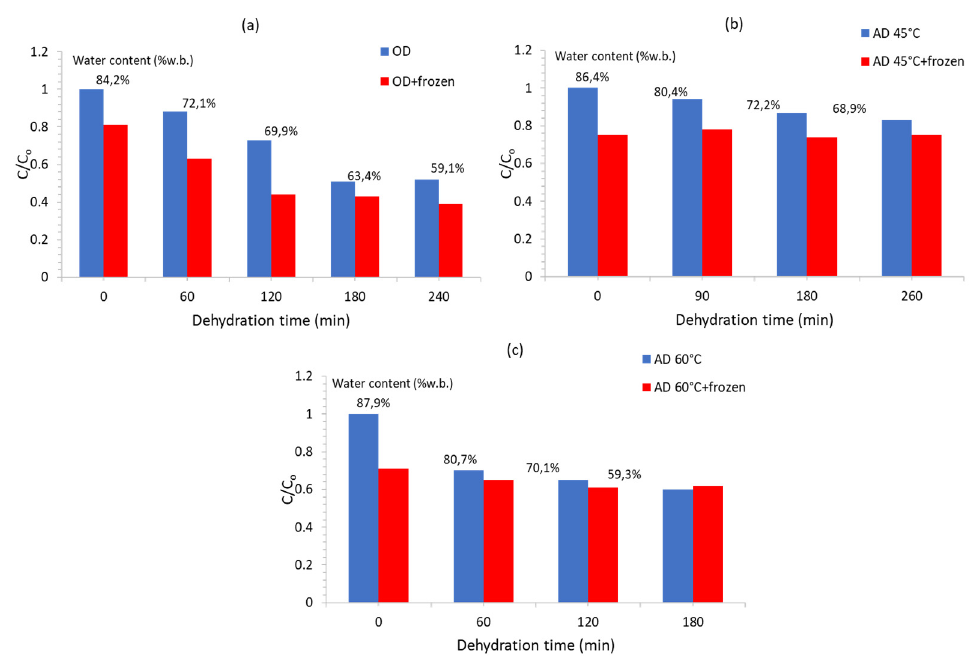
Figure 2. Vitamin C retention in pineapple slices during ( a ) osmotic dehydration at 45 °C–60 °Brix and ( b ) air drying (AD) at 45 °C and ( c ) air drying (AD) at 60 °C prior to freezing and after the freezing/thawing process. (data adopted from [28]). Percentages presented above the bars indicate the respective water content of samples (expressed on a % wet basis).